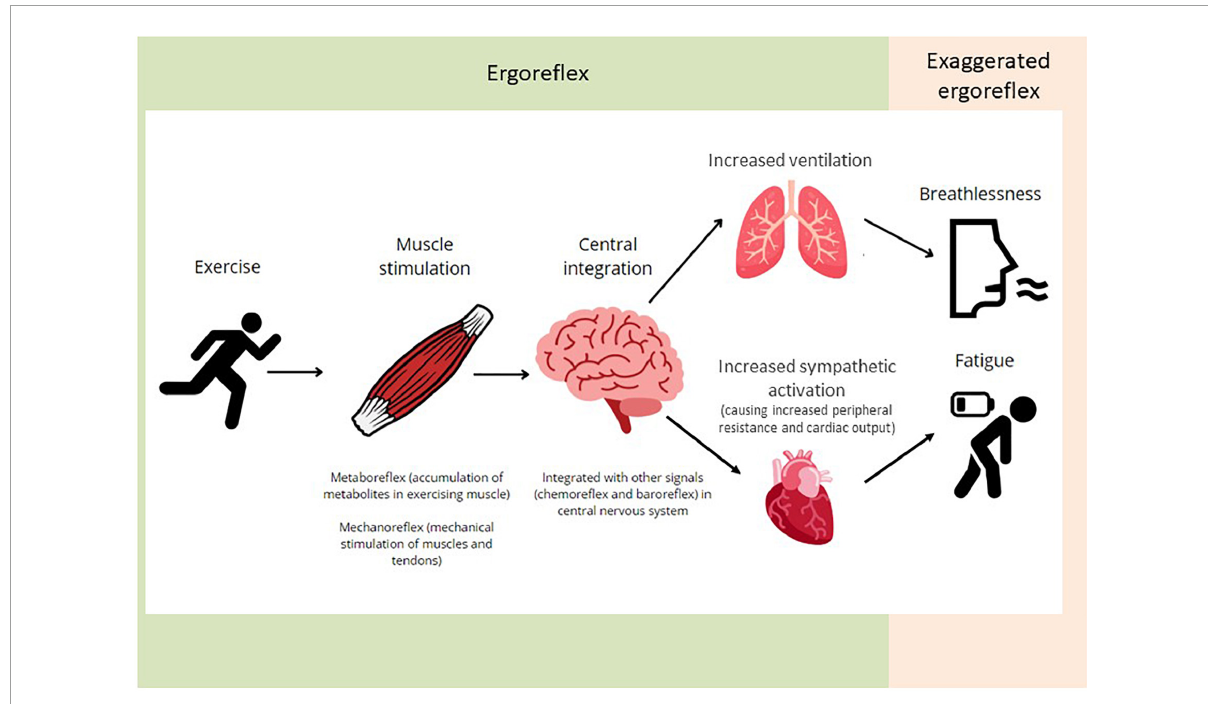
FIGURE1 An illustration of the ergoreflex. Skeletal muscle exercise causes stimulation of the metabo- and mechano-receptors. The signals are integrated centrally and contribute to the ventilatory and cardiovascular responses to exercise. Exaggerated ergoreflex (e.g., heart failure) leads to excessive response relative to work performed, leading to the sensation of breathlessness and